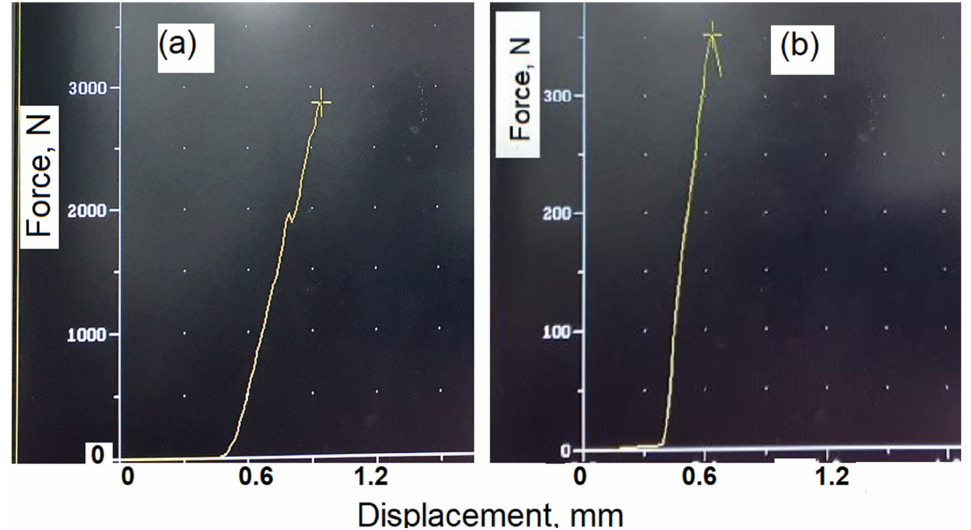
Figure 7. The force–displacement curves (stress–strain behavior) for the compression test; ( a )—hot